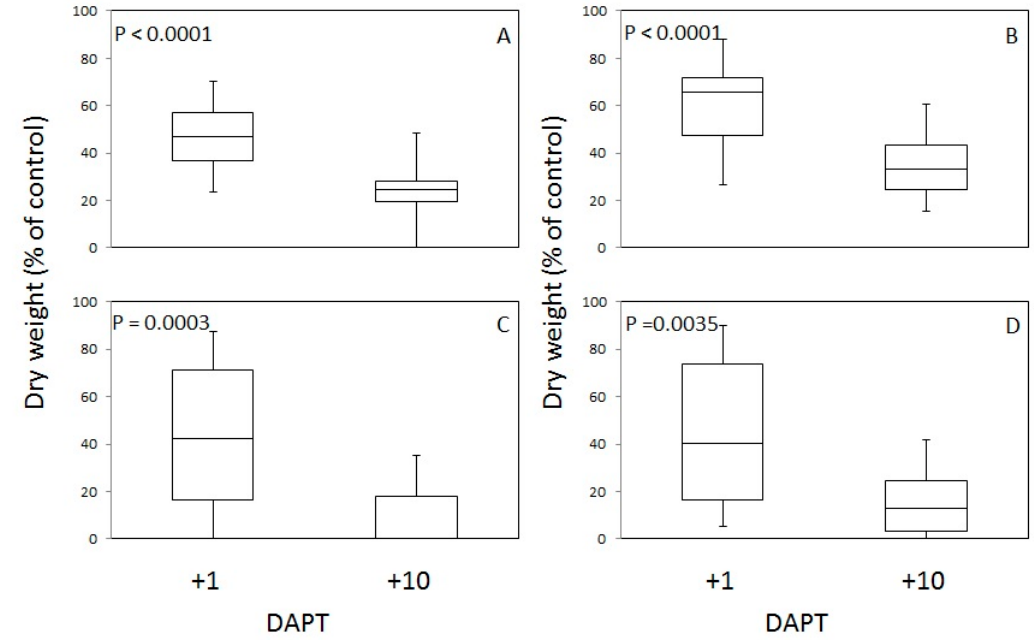
Figure 2. The impact of third treatment timing (1 or 10 days after previous treatment (DAPT)) on the above-ground dry weight ( A ), root dry weight ( B ), number of rhizomes ( C ), and seed weight ( D ) (% of untreated control) of Sorghum halepense . p -values were determined by Student’s t -test. Values are mean ± SE ( n = 7).